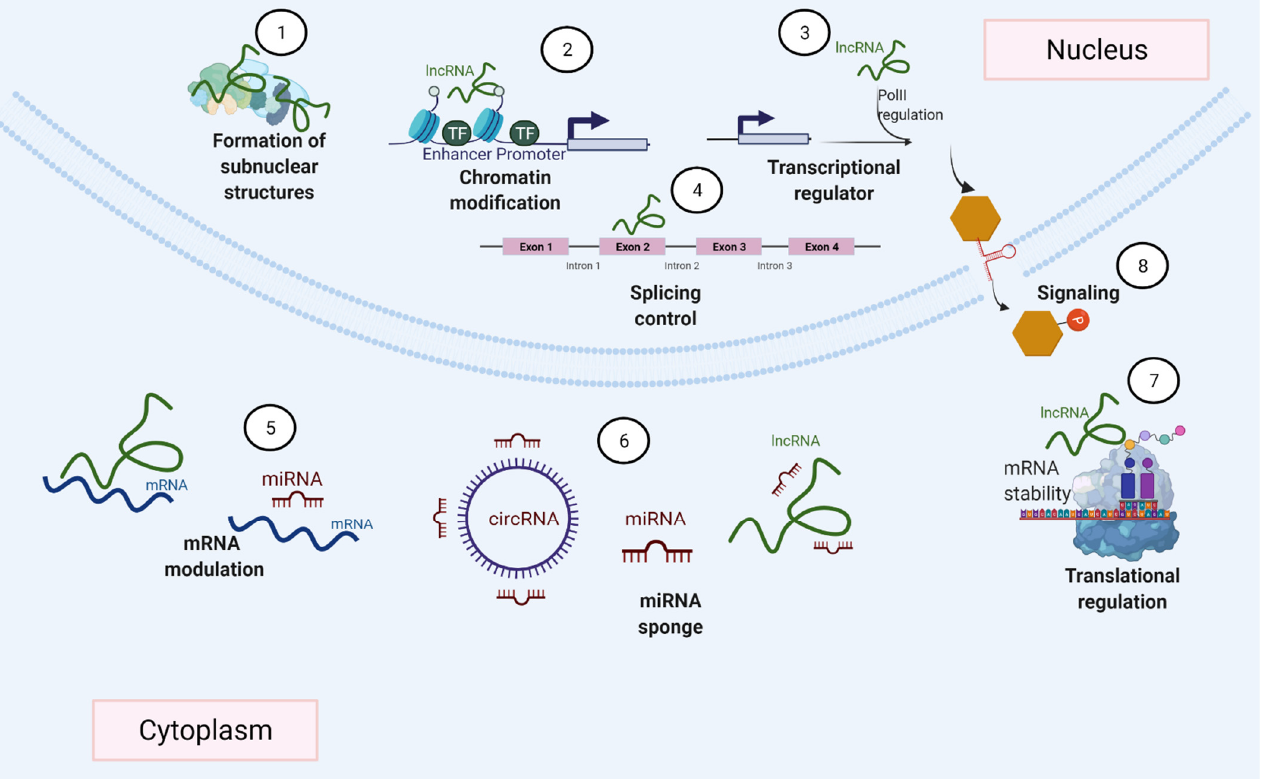
Figure 2. ncRNAs can regulate gene expression by diverse mechanisms. ncRNAs participate in the formation of nuclear bodies (1), gene transcription (2–3), modulate splicing events (4), regulate mRNA by degradation or stabilization (5), act as miRNA sponges (6), and ncRNAs can also be involved in the control of transcription (7) and cell signaling (8).